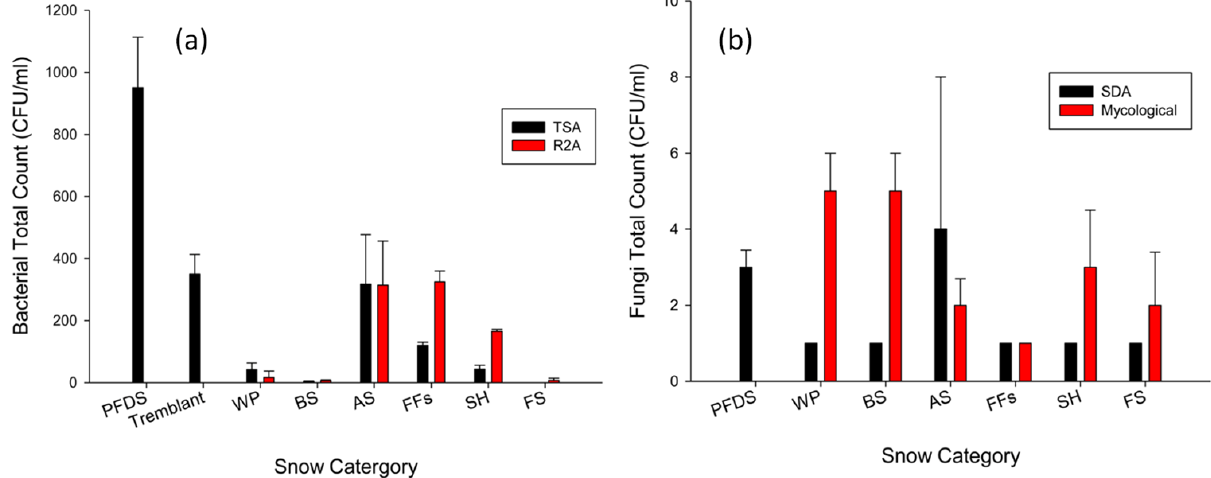
Figure 3. Concentration of viable cultivable bacteria and fungi in Arctic samples. Mean number of colony-forming units (CFUs) mL − 1 of snow on two media for: (a) bacteria (TSA and R2A) and (b) fungi (SDA and mycological agar) in each Arctic snow categories: accumulated snow (AS), blowing snow (BS), fresh snow (FS), surface hoar snow (SH), windpack (WP), and frost flowers (FFs). Samples from several urban sites collected in Quebec, Canada: Pierrefonds (suburb of Montreal; “PFDS”), and Mont-Tremblant (Laurentians; “Tremblant”) are included for comparison. Error bars indicate standard deviation (SD) of the mean for three